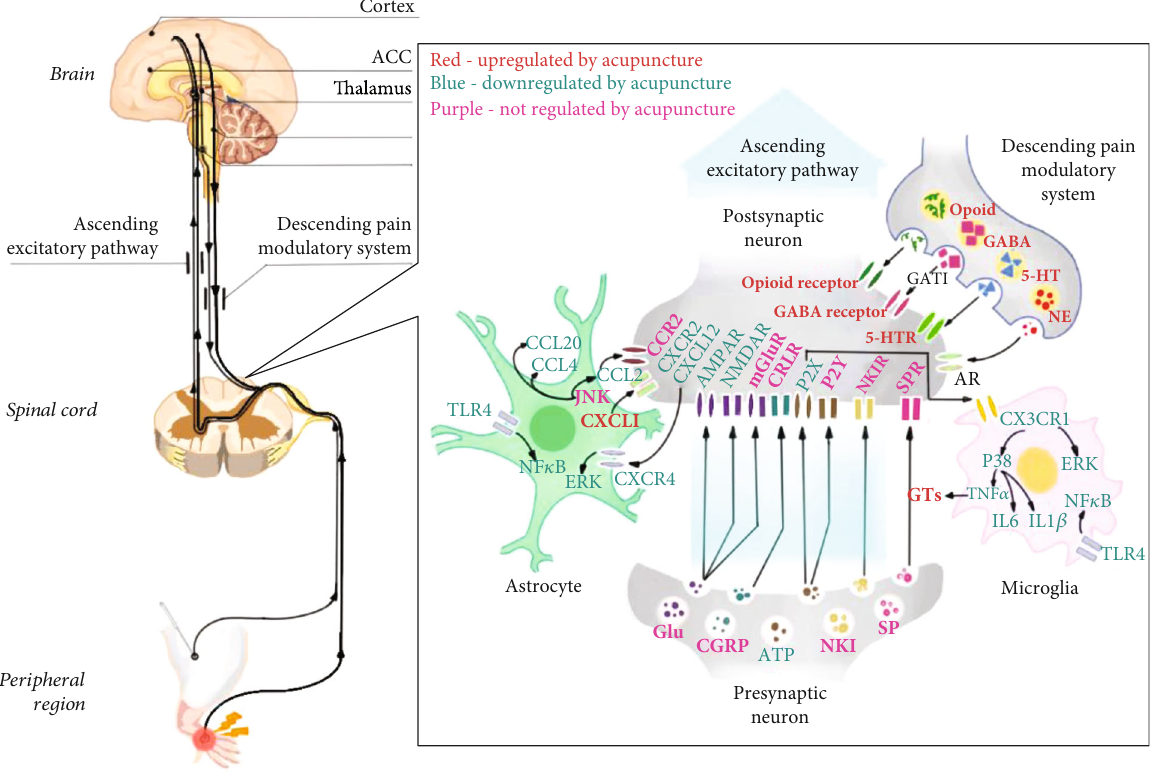
Figure 2: Role of neuroglial crosstalk and synaptic plasticity mediated central sensitization in acupuncture analgesia. The titles of neurotransmitters, neuropeptides, and immune factors are presented in red, blue, and purple, as the fi gure shows. Factors in red are upregulated by acupuncture, while factors in blue are downregulated by acupuncture. Factors in purple are activated or inhibited in the central sensitization process but are not regulated by acupuncture. ACC: anterior cingulate cortex; PAG: periaqueductal gray; RVM: rostral ventromedial medulla; GABA: ?-aminobutyric acid; 5-HT: 5-hydroxytryptamine; 5-HTR: 5-hydroxytryptamine receptor; NE: norepinephrine; AR: adrenergic receptor; GAT1: GABA transporter 1; Glu: glutamate; AMPAR: α -amino-3-hydroxy-5-methyl-4- isoxazolepropionic acid receptor; NMDAR: N -methyl- D -aspartate receptor; mGluR: metabotropic glutamate receptors; CGRP: calcitonin gene-related peptide; CRLR: calcitonin receptor-like receptor; ATP: adenosine triphosphate; P2X: P2X receptor; P2Y: P2Y receptor; NK1: neurokinin-1; NK1 receptor: neurokinin-1 receptor; SP: substance P; SPR: substance P receptor; CX3CL1: C-X3-C motif chemokine